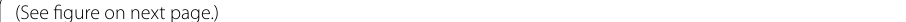
figure on next Fig. 2 The signaling pathway of RCAN1 in tumor progression. A RCAN1 inhibits CN activity by blocking the CN-essential substrate recruitment site, LxVP and PxIxIT interaction grooves, by using its LxVP and PxIxIT motif. The inhibition of CN by RCAN1 can be weakened by phosphorylation of RCAN1. B RCAN1-regulated CN. RCAN1 inhibits CN-NFAT pathway and NFAT-regulated gene transcription, including IGF-1, VEGFA, ANG-2, IFI27, CXCL8, IL-8, and IL-11. C CN-independent RCAN1 regulation. GC binds to GREs in the RCAN1.1 transcription start site, inducing apoptosis cells. RCAN1 inhibits NFE2L3 and the NF-κB signaling